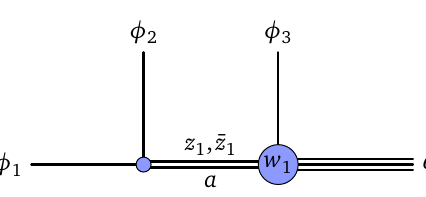
Figure 2 . One of the four-point functions obtained in the OPE limit for the middle leg in a six-point function in comb channel. The rightmost field is a mixed symmetry tensor with two spin indices and the exchanged field is a symmetric traceless